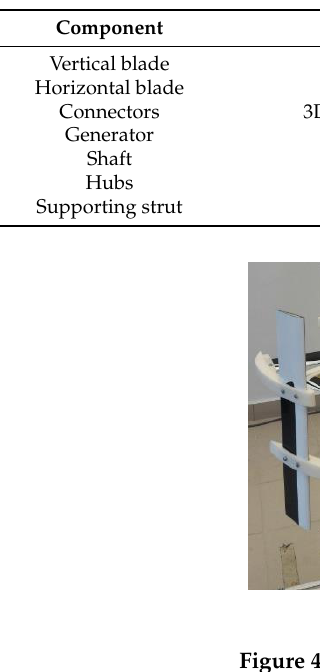
Table 1. Materials selection for the CAWT and VAWT.